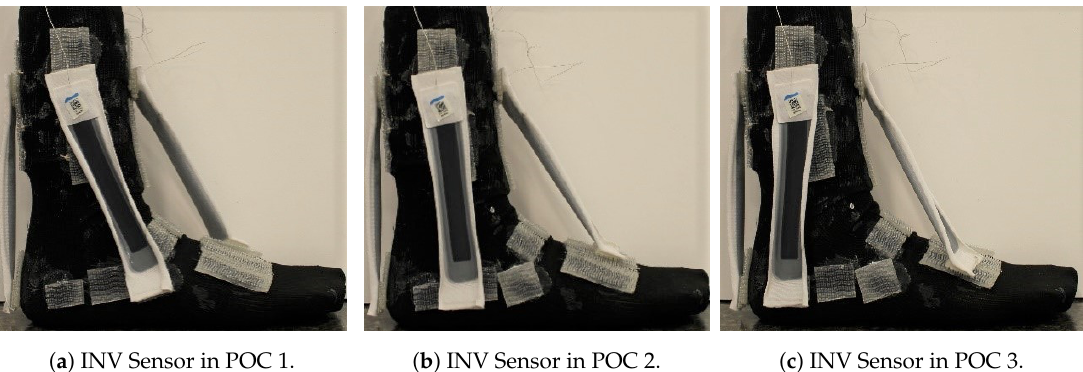
Figure 4. INV Sensor POC Positions: ( a ) POC 1; ( b ) POC 2; and ( c ) POC 3.